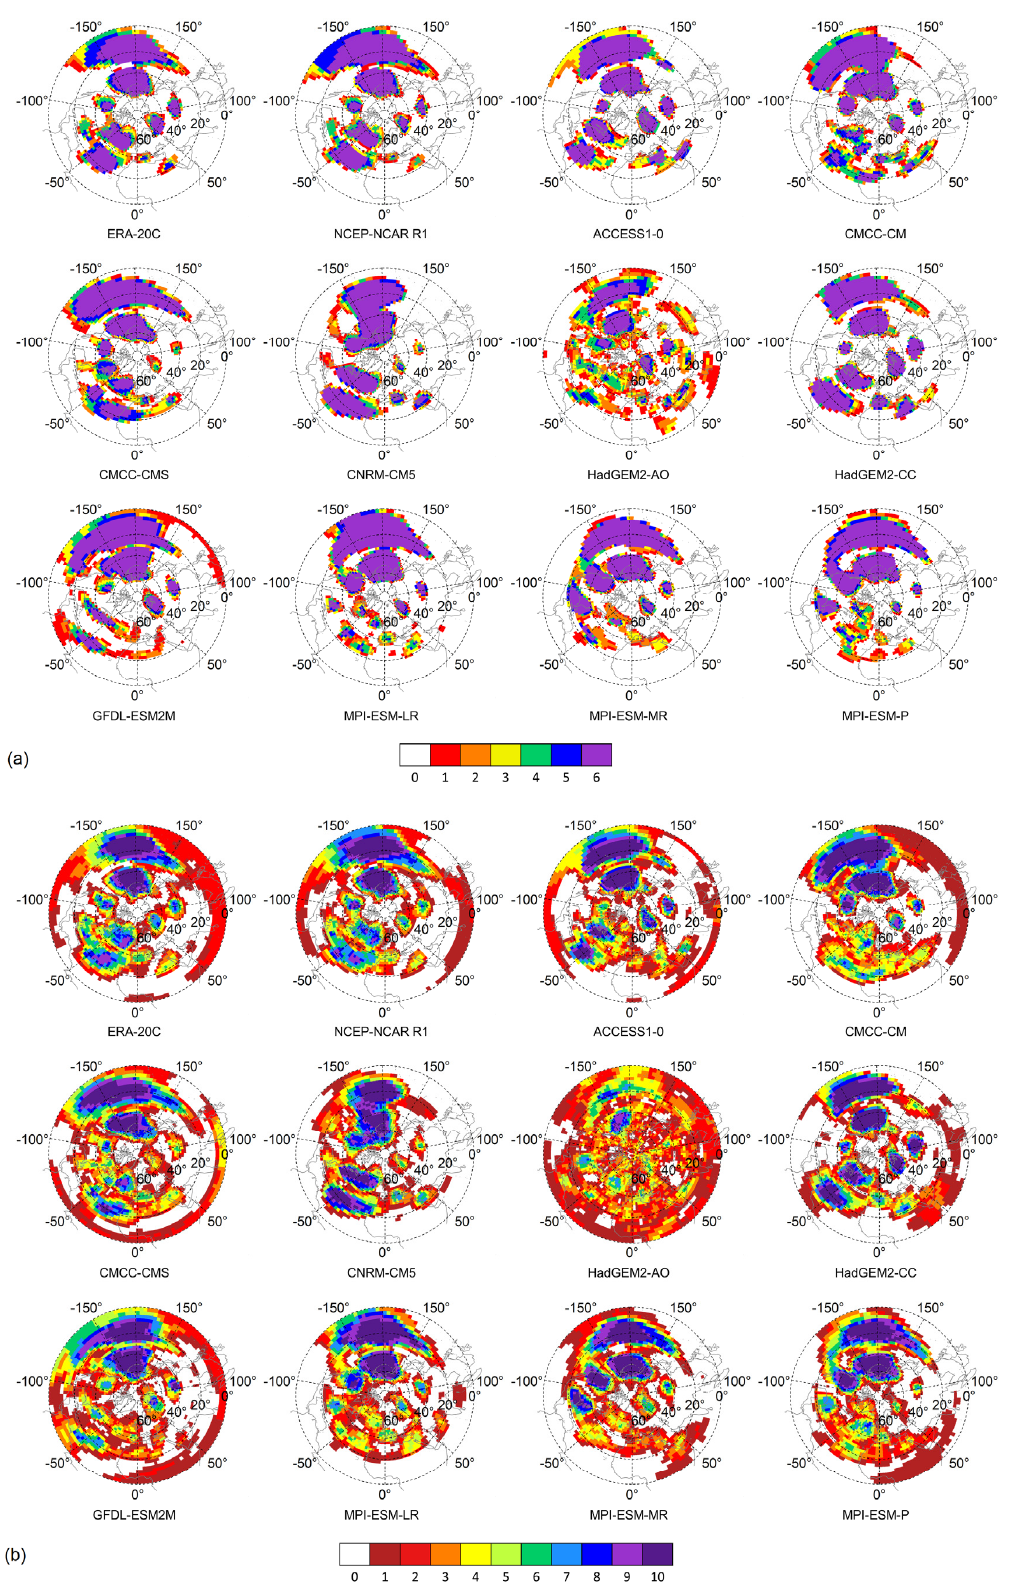
Figure 2. Stability patterns of selected reanalyses/GCMs ( a ) in the case of the 30-year-long periods and ( b ) in the case of the 10-year-long periods. The number of time periods with the strongest negative correlation below the 25th percentiles of all correlations is shown in each grid cell.